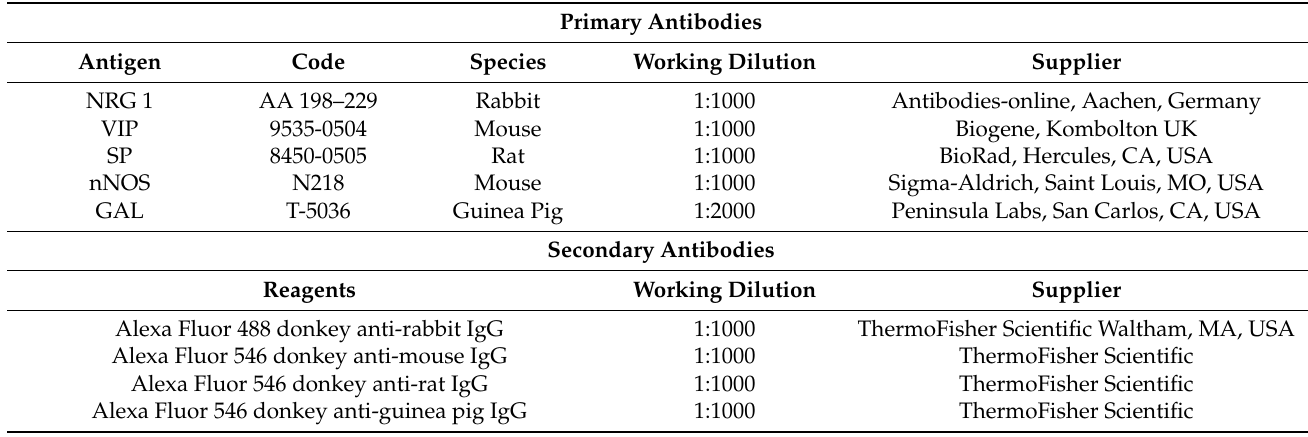
Table 4. The list of antisera and reagents used in immunohistochemical